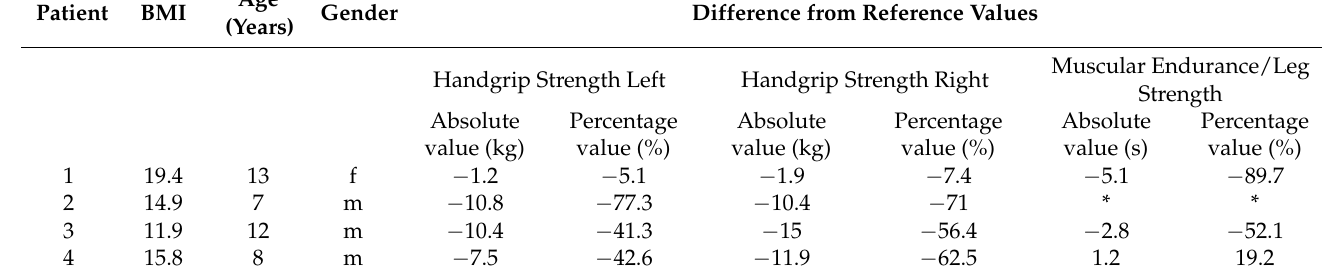
Table 2. Anthropometric and physical capacity-related endpoints at baseline testing T0 compared to age- and gender-specific reference